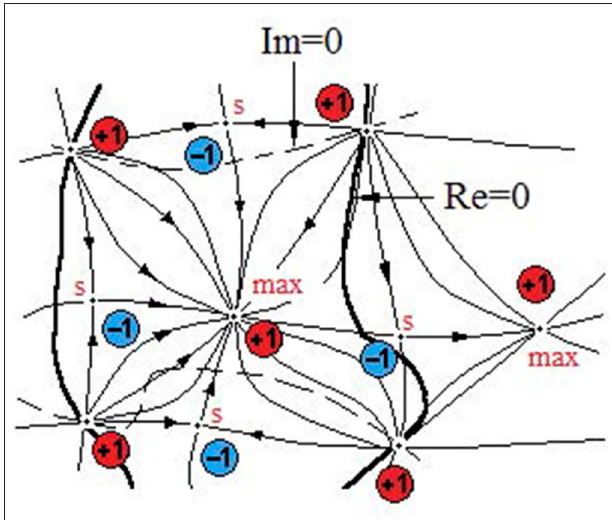
FIGURE 3 | Nets of the special points of intensity and singular points of phase formed by the intensity-gradient streamlines and by the phase threshold lines (PT-lines). Poincaré indices are indicated for the intensity maxima (max), OVs (absolute minima, red circles), and for the saddle points of intensity (S) (blue circles) [